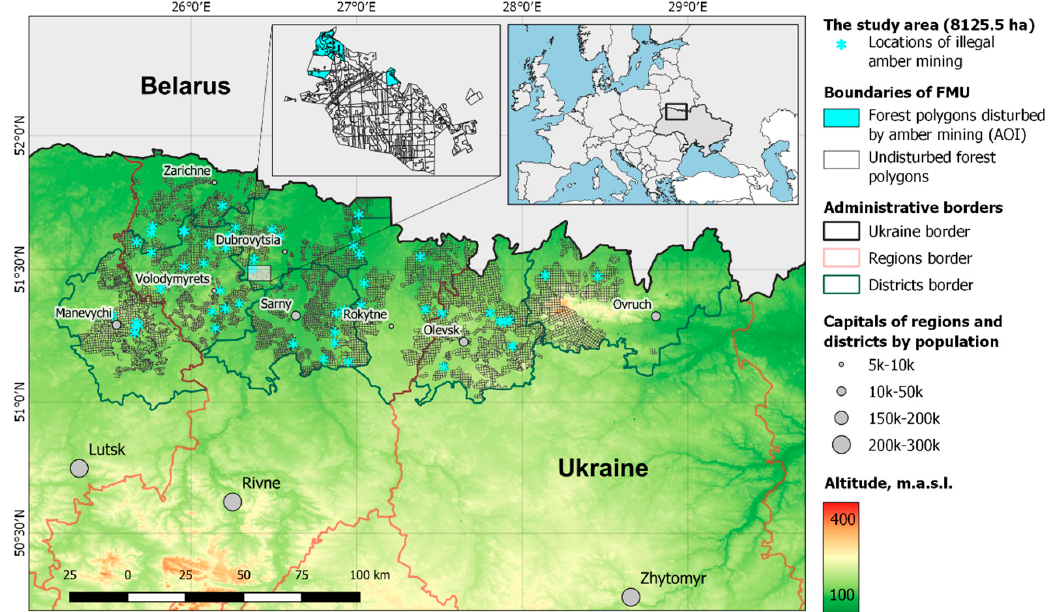
Figure 1. The location of the study area within eight administrative regions of Ukraine (the city of Lutsk is the capital of Volyn region; the terrain base map comes from the Shuttle Radar Topography Mission (SRTM) with a 90-m spatial resolution).